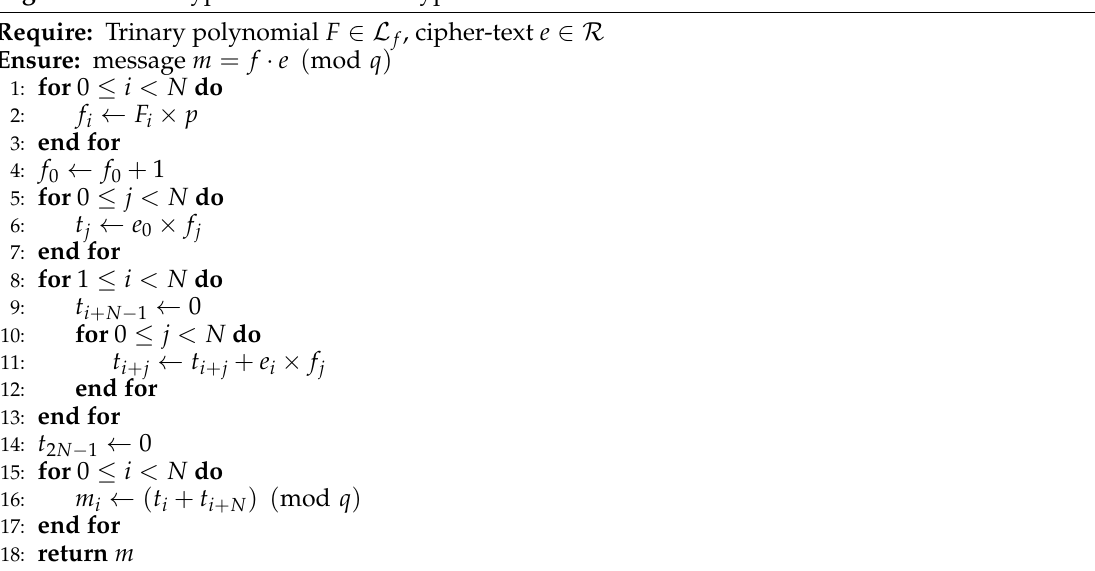
Algorithm 3 Decryption in